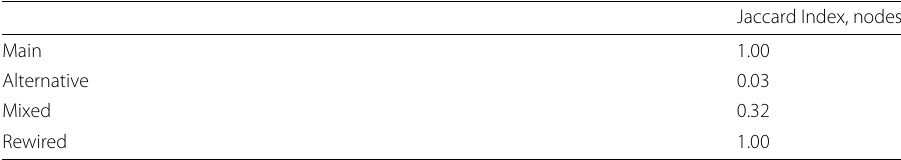
Table 2 Node similarity, compared to the Main network